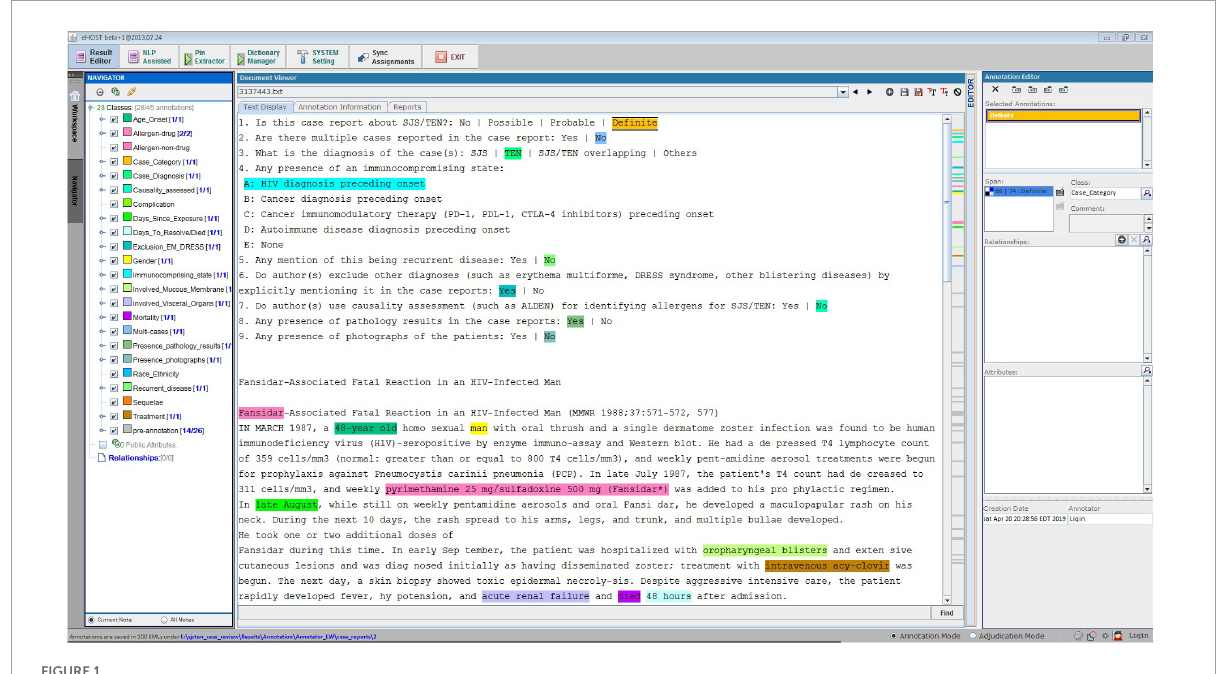
FIGURE1 Case report annotation